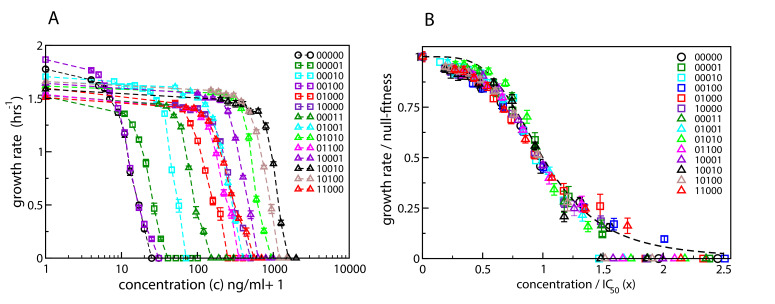
Dose-response curves for E. coli in the presence of ciprofloxacin.Each binary string corresponds to a strain, where the presence (absence) of a specific mutation in the strain is indicated by a 1 (0). The five mutations in order from left to right are S83L (gyrA), D87N (gyrA), S80I (parC), ΔmarR, and ΔacrR. The names of the strains are given in Table 1. (A) Dose-response curves of the wild type, the five single mutants and eight double mutants. Unlike the experiments reported in Marcusson et al., 2009, the mutants were grown in isolation rather than in competition with the wild type. (B) The same curves, but scaled with the null-fitness and IC50 of each individual genotype. The dashed black line is the Hill function (1+x4)-1.